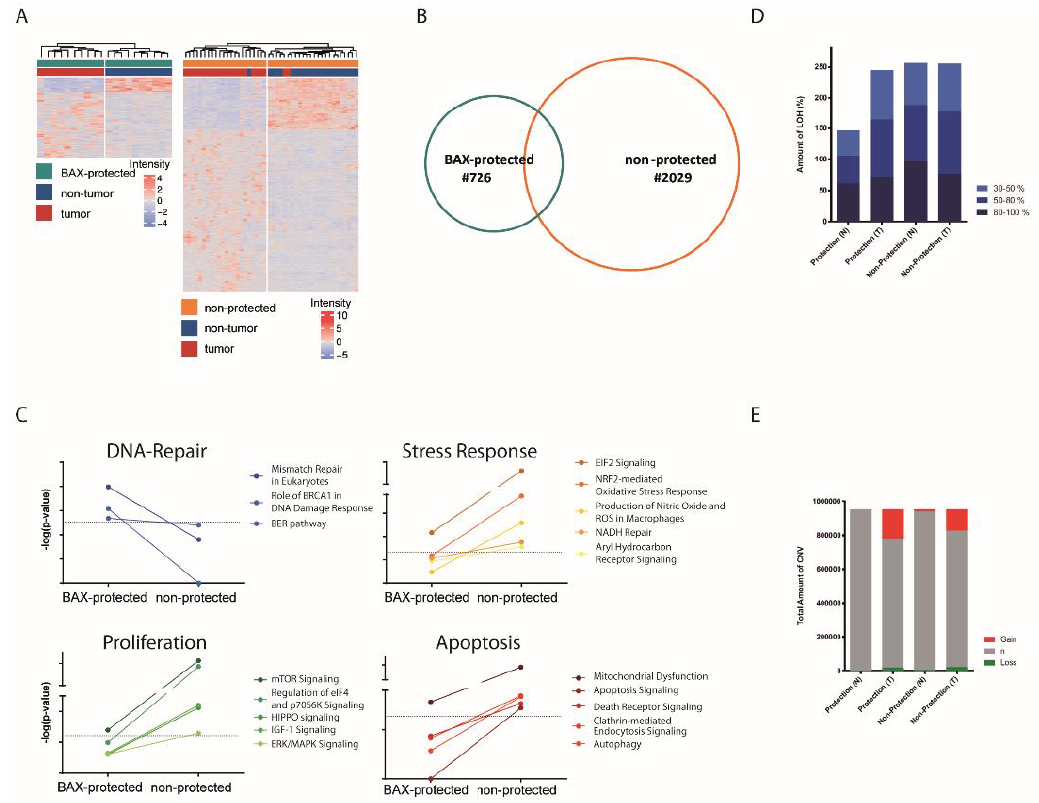
Figure 3. ( A ) Unsupervised clustering analyses based on corresponding genes differently regulated between non-tumorous and tumor tissue in BAX-protected and non-protected subgroups. ( B ) Venn diagram demonstrating the overlap of differentially regulated genes in BAX-protected and non-protected tumor subgroups during malignant transformation. ( C ) Activated signaling pathways during malignant transformation examined by comparative ingenuity pathway analyses based on BAX-protected and non-protected tumor subgroup transcriptome profiles. ( D ) Presence of loss of heterozygosity (LOH) in percentage based on SNP array analyses for BAX-protection and non-protection in non-tumorous and tumor tissue. ( E ) Copy number alterations based on SNP array analyses for BAX-protected and non-protected tumor subgroup in non-tumorous and tumor tissue. Table 1. Top molecular and cellular functions identified by Ingenuity Pathway Analysis in the protection and non-protection subgroup during malignant transformation.